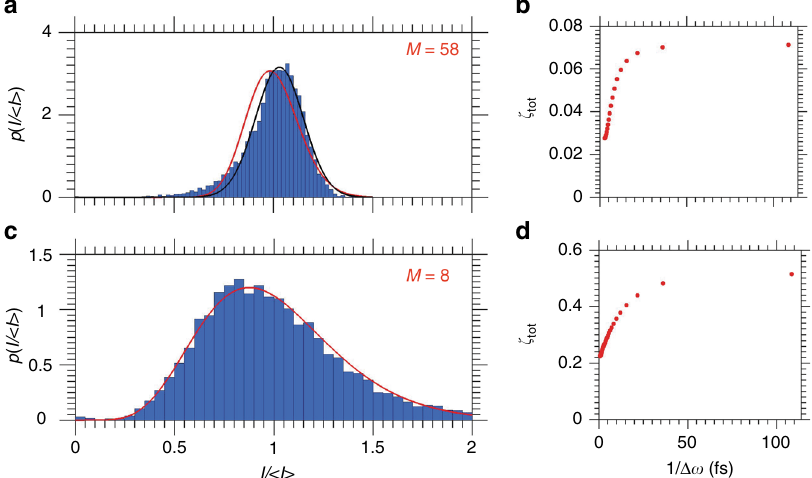
Fig. 4 Histograms and dispersion values of intensity in different modes of operation. a , c Histograms of probability distributions of intensity, p(I/ 〈 I 〉 ), for seeded ( a ) and self-ampli fi ed spontaneous emission (SASE) ( c ) regimes. The red line represents a fi t by a Gamma function and the black line represents a fi t by a Gaussian function. Number of modes determined from the Gamma distribution is indicated by M . ( b , d ) Contrast behaviour as a function of inverse bandwidth for seeded ( b ) and SASE ( d ) regimes of